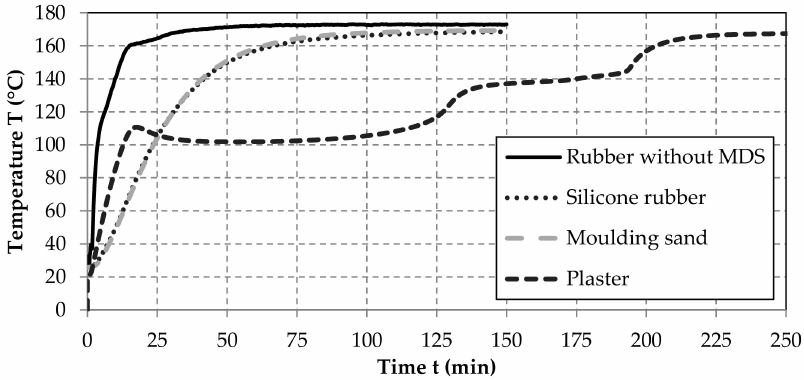
Figure 4. Time curves until the vulcanization temperature is reached inside the dumbbell